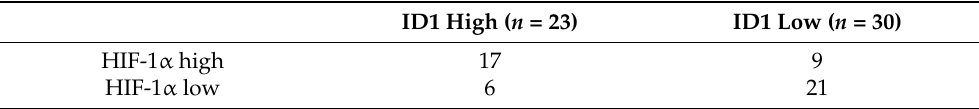
Figure 3. The correlation of ID1 and HIF-1 α in clinical samples. ( A ) Representative IHC staining images of ID1/HIF-1 α -high (upper panel) and ID1/HIF-1 α -low (lower panel) surgically resected HCC tissue specimens. ( B ) Correlation of ID1 and HIF-1 α in HCC patient samples. The p value was calculated by the chi-squared test. Table 2. ID1 and HIF-1 α expression in HCC patient samples.